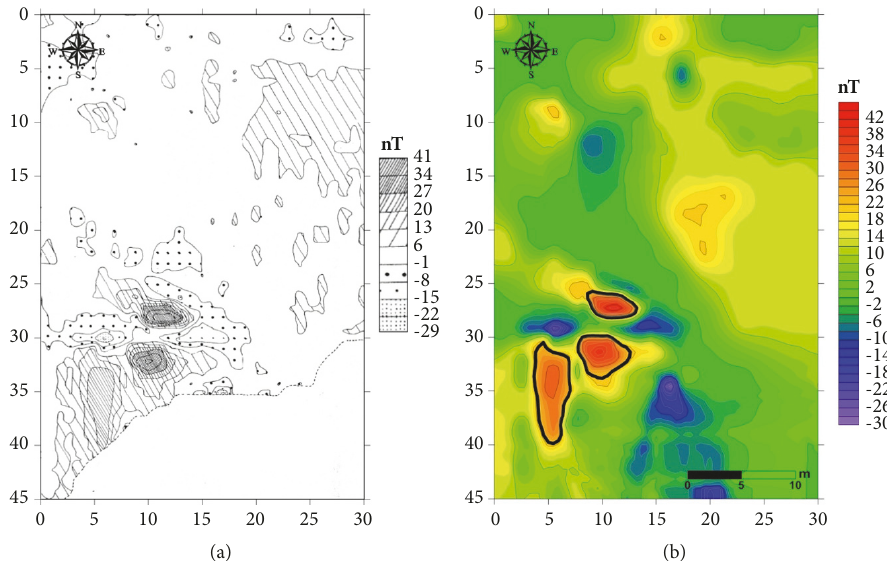
Figure 4: Magnetic map of the archaeological site of A¨ın Kerouach: (a) original map; (b) gridded